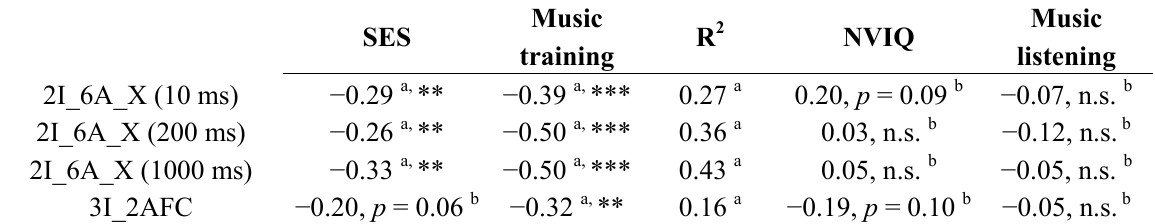
Table 2. Standardised regression coefficients for the four different outcome measures (2I_6A_X, n = 73; 3I_2AFC, n = 86). a Values summarise the regression weights of the final model. b Nonsignificant regression weights observed during exploratory analyses but subsequently removed from the final models. ** p < 0.01, *** p < 0.001, n.s. (nonsignificant), p >